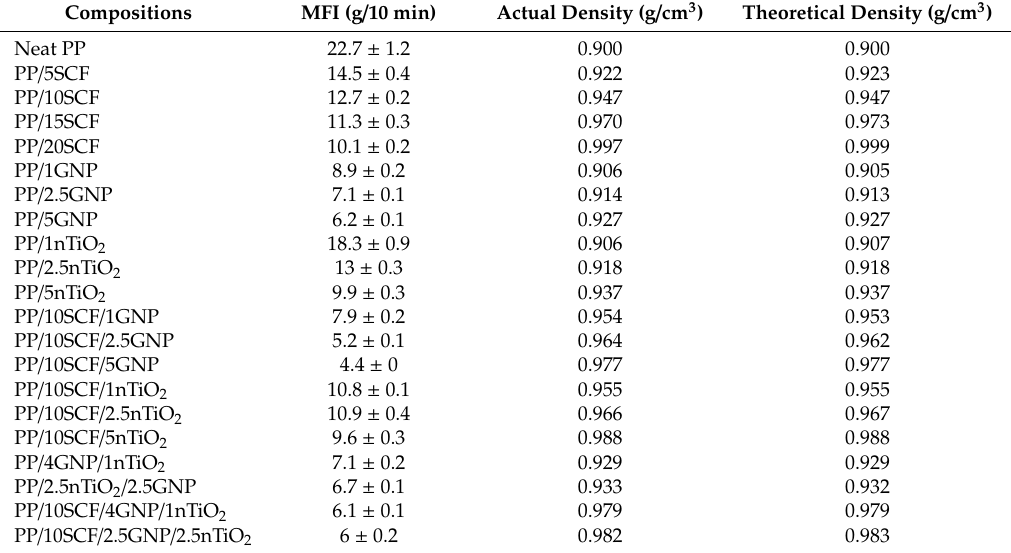
Table 5. Melt flow index (MFI), actual density and theoretical density of the polypropylene (PP)